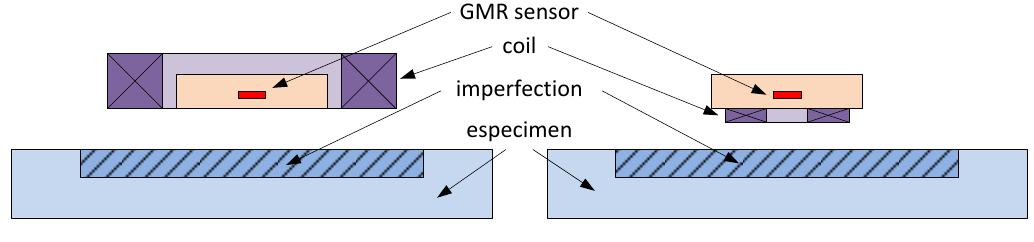
Figure 11. Possible geometric arrangements of coils with GMR sensors for ECT